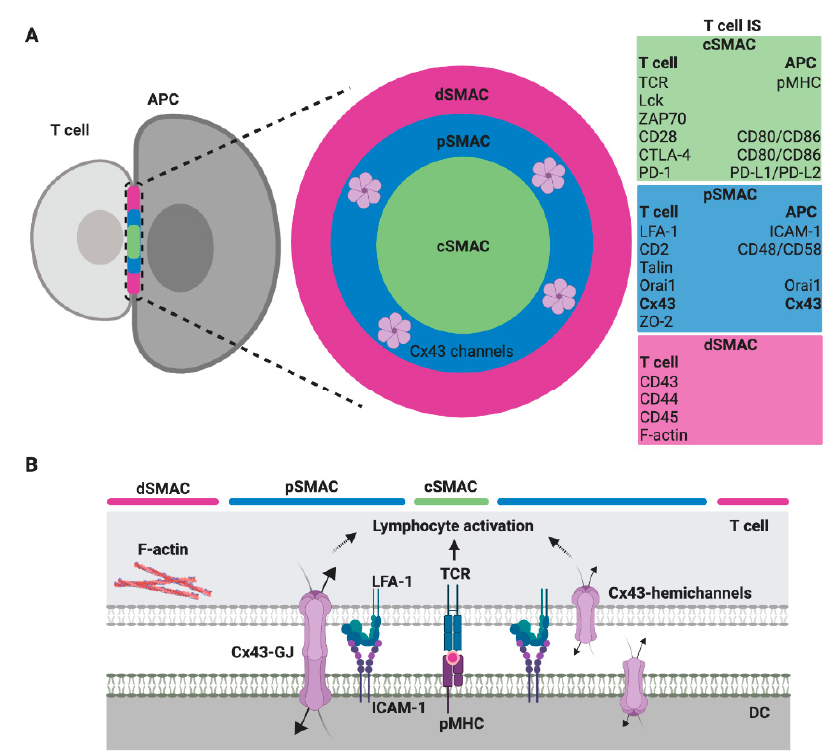
Figure 1. Scheme of a T cell immunological synapse (IS) and localization of Cx43 formed gap junctions (GJ) in the SMAC. ( A ) A face on view of the IS with the characteristic SMAC patterns, including the cSMAC (green), the pSMAC ring surrounding the cSMAC (blue) and the distal region to the synapse outside the pSMAC (dSMAC, red), as well as the molecules / ligand that are found enriched within. The evidence suggests that gap junction (GJ) channels formed by Cx43 (Cx43-GJ), as well as Cx43 hemichannels, are located in the pSMAC region [13]. ( B ) A profile view showing a selection of key ligand pairs and Cx43 channels (GJ and hemichannels) that are involved in DC-mediated T cell activation.